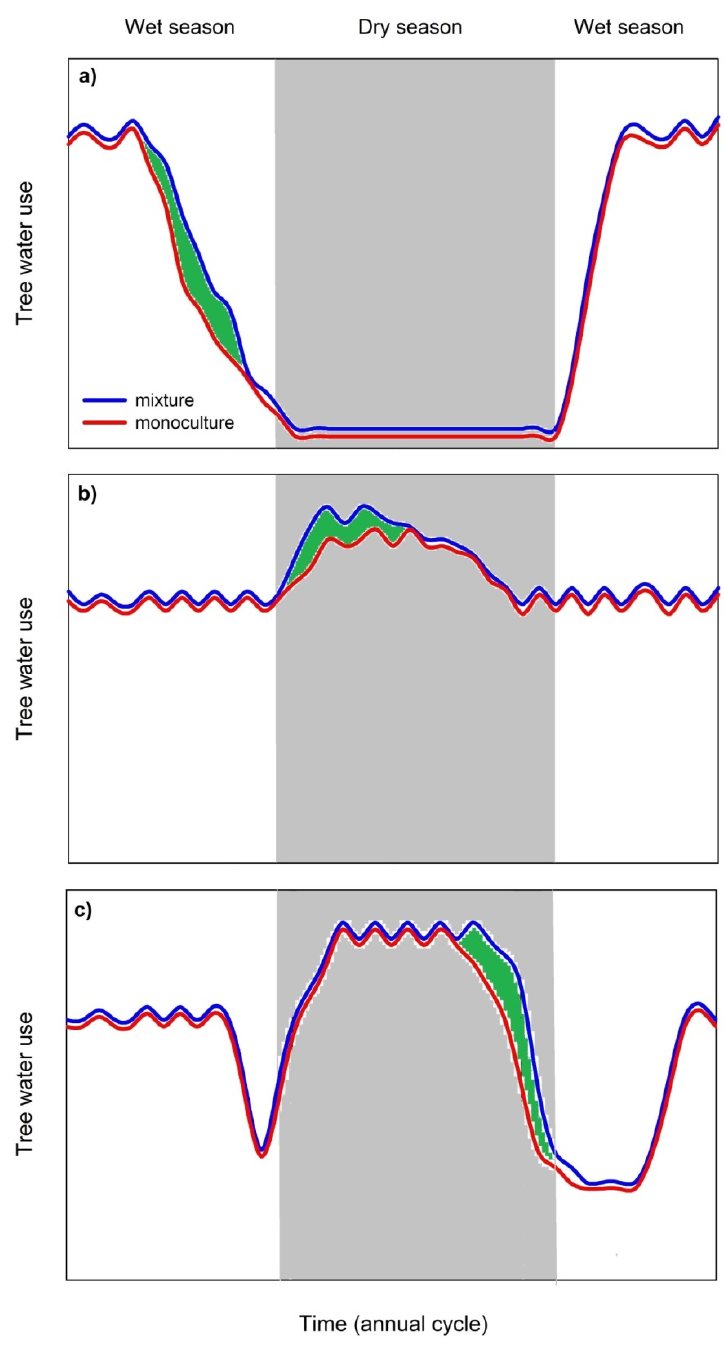
Figure 2. Schematic annual course of water use of three different tree species with different water use strategies and the differences between a given species growing in monoculture (red lines) or a mixed species plot (blue lines) compiled after Kunert et al. [26]. Green shaded area between the blue and red line represents the time lack between trees getting water limited growing in monoculture and trees growing in mixed stand. This time lack is probably due to complementarity in water use in the mixed species plots. ( a ) Annual course of a typical drought avoiding species ( Cedrela odorata ) with only minimal transpirational water loss during the dry season (grey shaded area); ( b ) dry season green species with leaf senescence (e.g., Luehea seemannii ); and ( c ) Tabebuia rosea maintaining the canopy fully foliated during the dry